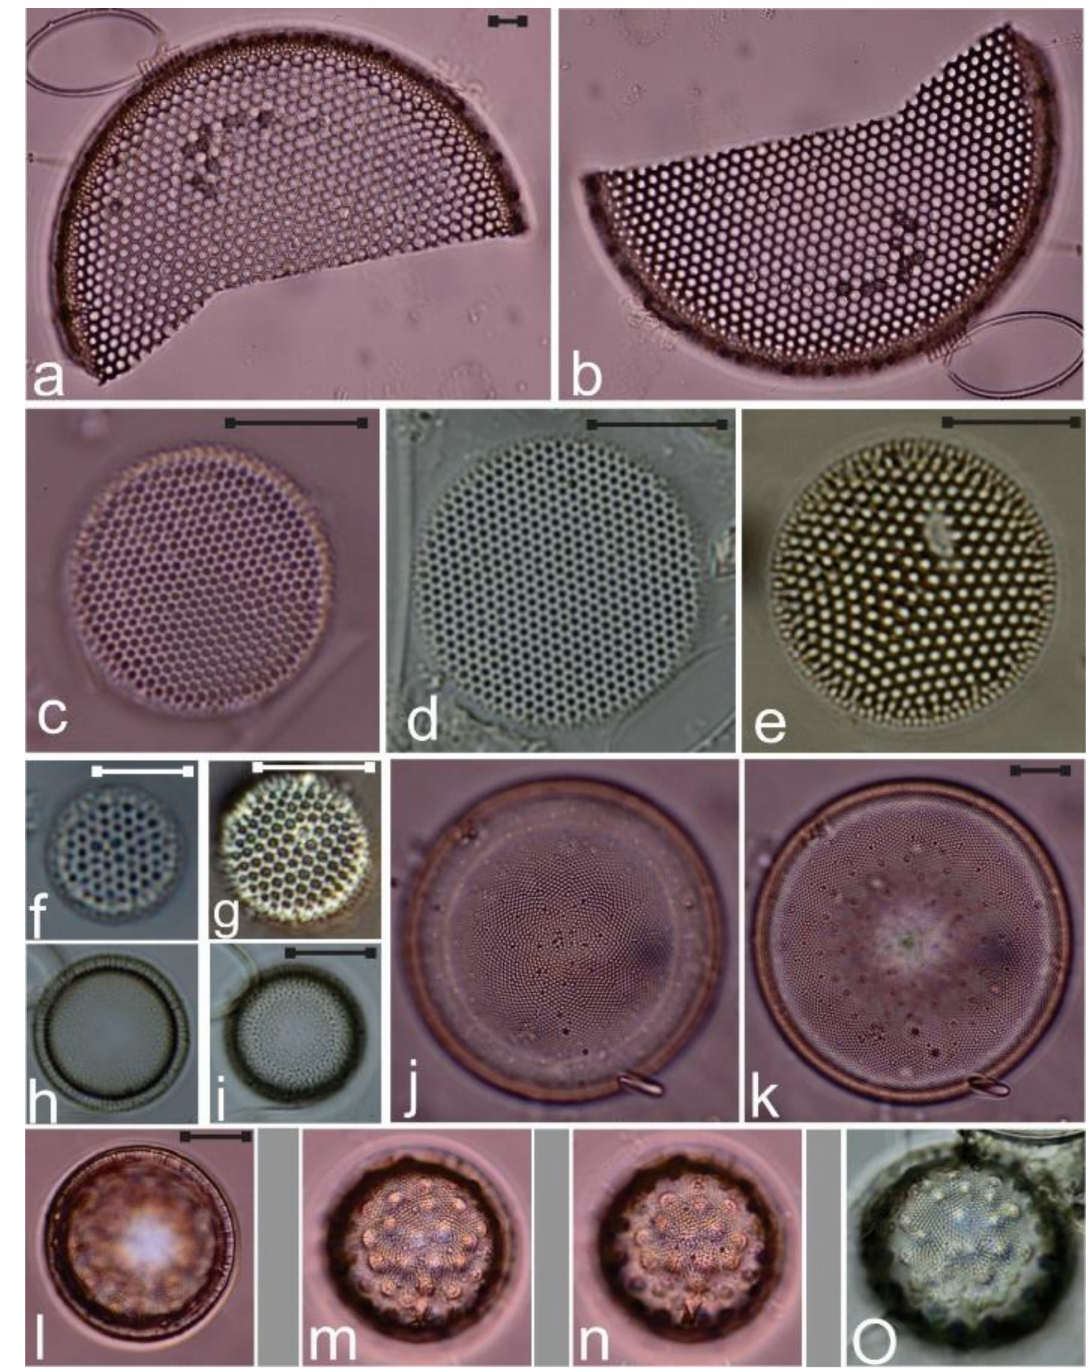
Figure 6. ( a , b ) Thalassiosira leptopus valve fragment in two focal planes; ( c , d ) T. lineata focus showing the rimoportulae; ( e ) T. eccentrica ; ( f , g ) T. decipiens ; ( h , i ) Melosira moniliformis var. octogona ; ( j , k ) Coscinodiscus mesoleius ; ( l – o ) Margaritum terebro , image l focus showing a side view of the rimoportulae near the margin, images m – o focus showing rimoportulae papilliformis. Scale bar: a – e , h – n = 10 µ m; f = 5 µ